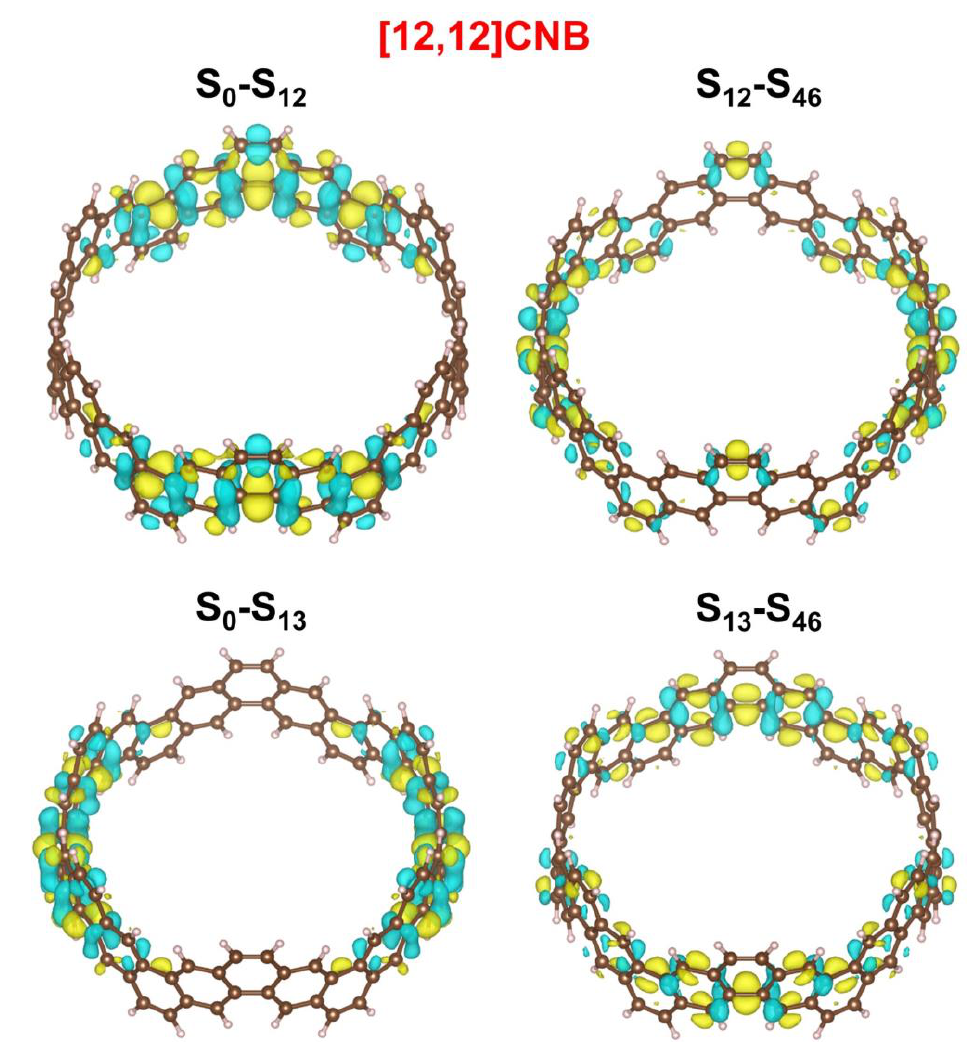
Figure 6. ( a ) TPA spectrum of [2N,2N]CNB. The absorption peak of the absorption spectrum is broadened by a Gaussian function, FWHM = 0.5 eV. ( b ) The relationship between the imum absorption peaks of [2N,2N]CNB and the size.